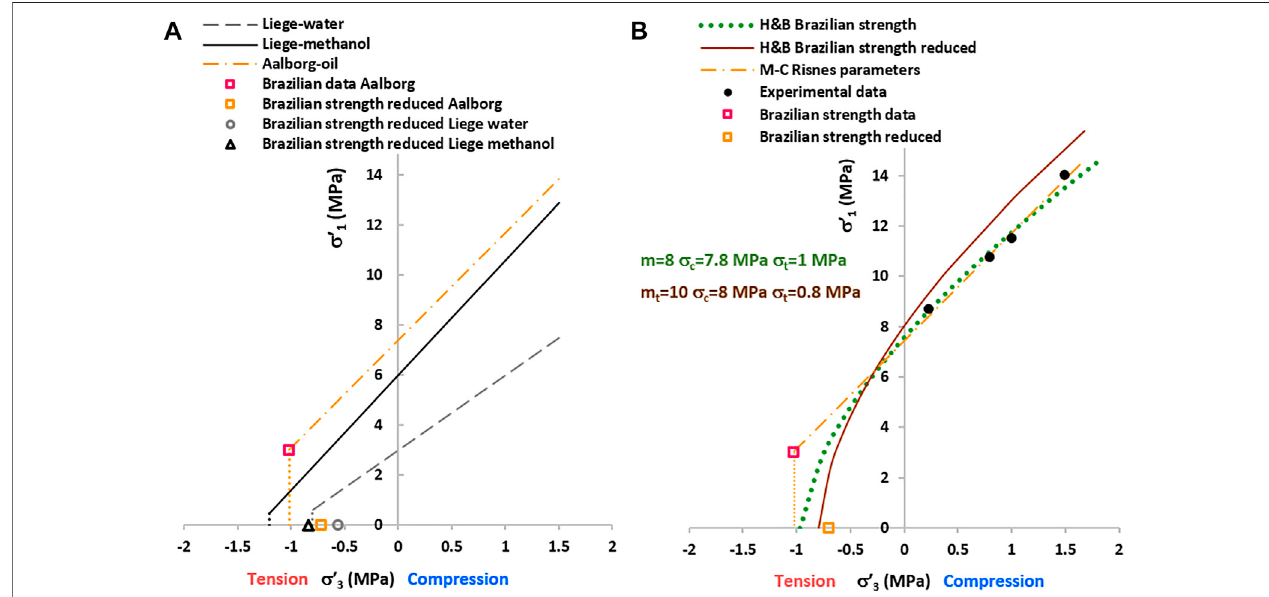
FIGURE 6 | (A) M-C strength envelopes of Liège and Aalborg chalks, calculated with the strength data of Risnes and Flaageng (1999) and Risnes (2001), respectively.Thedottedlinesarethecutoff.TheredsymbolrepresentsthedataoftheBraziliantest.TheotheropensymbolsrepresenttheBrazilianstrengthreducedby a factor of 0.7. (B) Data fi tting of Aalborg chalk tests and comparison with Risnes (2001) data fi tting.